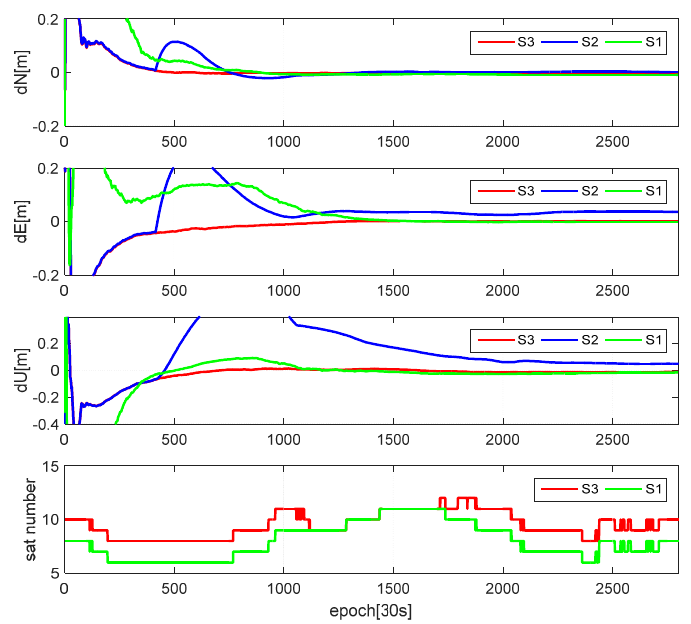
Figure 11. The positioning performance of BDS-only static PPP for three eclipsing strategies (JFNG station, DOY 195 of 2017, the sampling rate is 30 s).